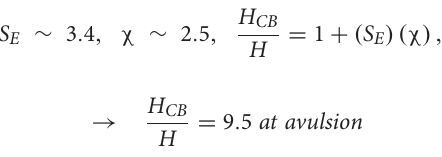
Figure 5 , the P 80 S Esubmarine = 3.4. Using the same reasoning for χ , the P χ value is 2.5 ( Figure 5 ). Revisiting Eq. 80 submarine